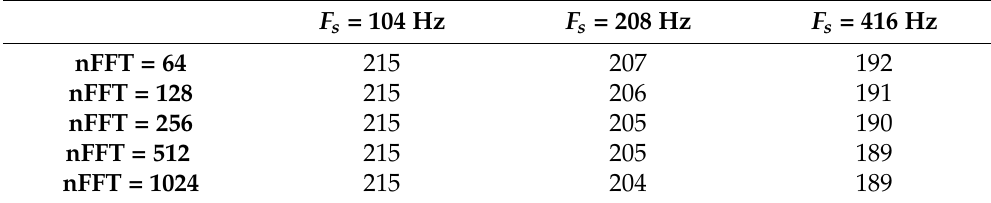
Table 6. Battery duration in hours for ST controller and operating mode T OFF =